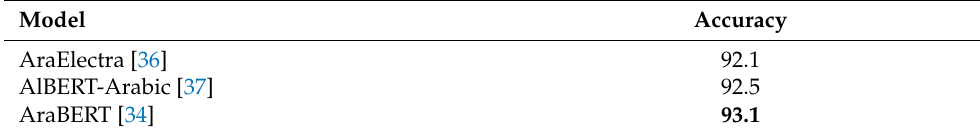
Table 5. Performance of different tuned transformer models.